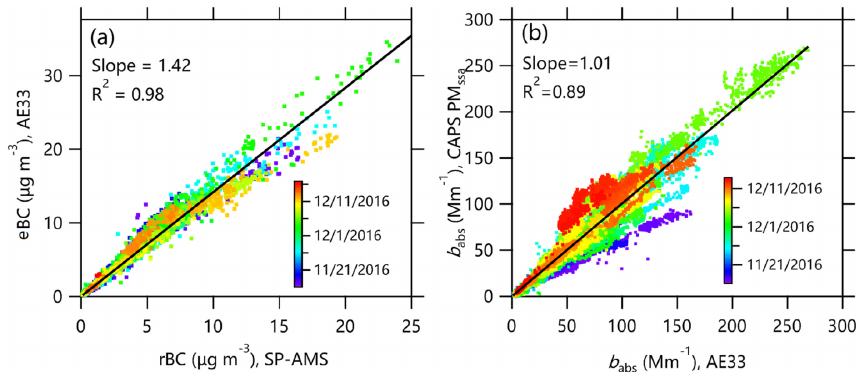
Figure 2. Comparisons of (a) BC measurements between AE33 and SP-AMS and (b) b abs calculated from the difference of b ext and b sca of CAPS PM ssa and derived from